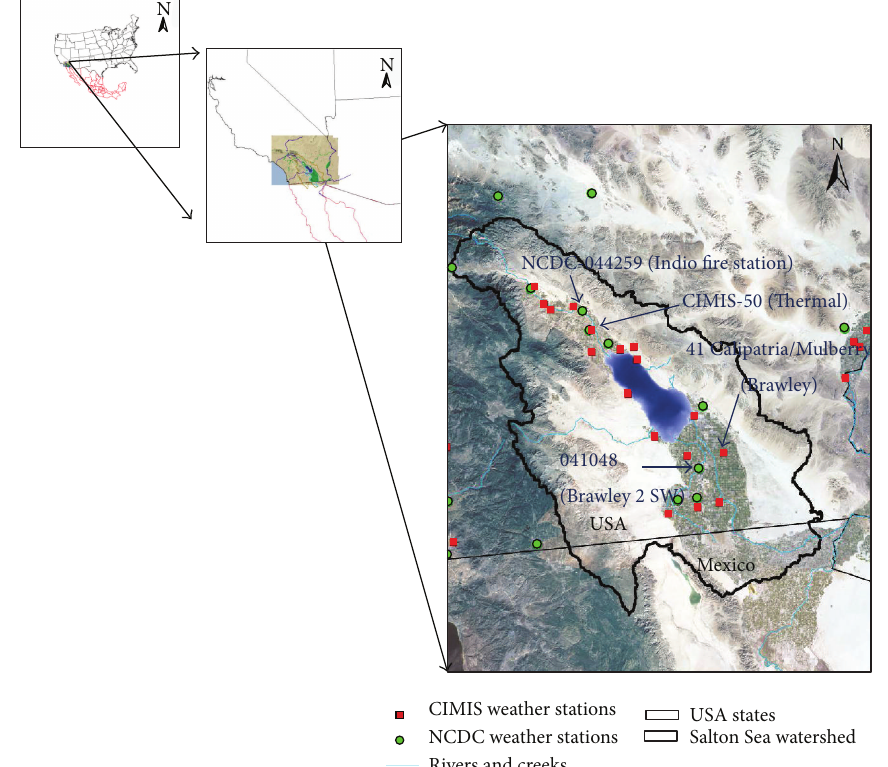
Figure 1: Geographic location of the Salton Sea and weather stations within the Salton Sea watershed. Shapefiles were obtained from Redlands Institute, University of Redlands